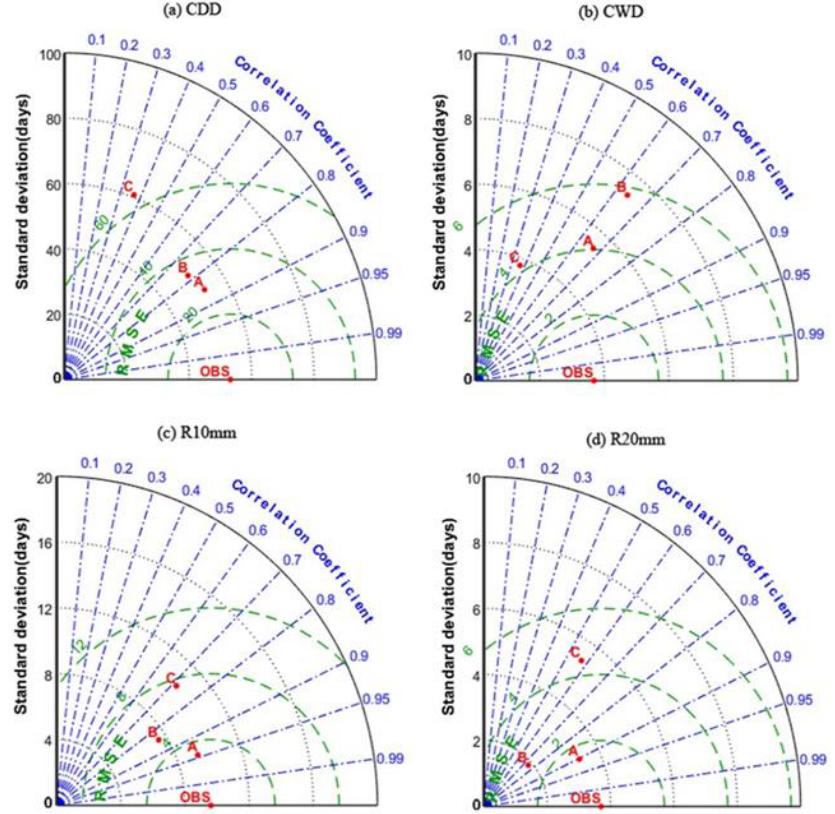
Figure 3. Taylor diagrams indicating correlation coefficients, standard deviation, and RMSE of CDD, CWD, R10mm, and R20mm indices from 1981 to 2014. ( A ) CMFD, ( B ) APHRODITE, and ( C ) CHIRPS. The radial coordinate (y axis) represents the magnitude of standard deviation, concentric semicircles represent RMSE, and the angular coordinate represents the correlation coefficient.